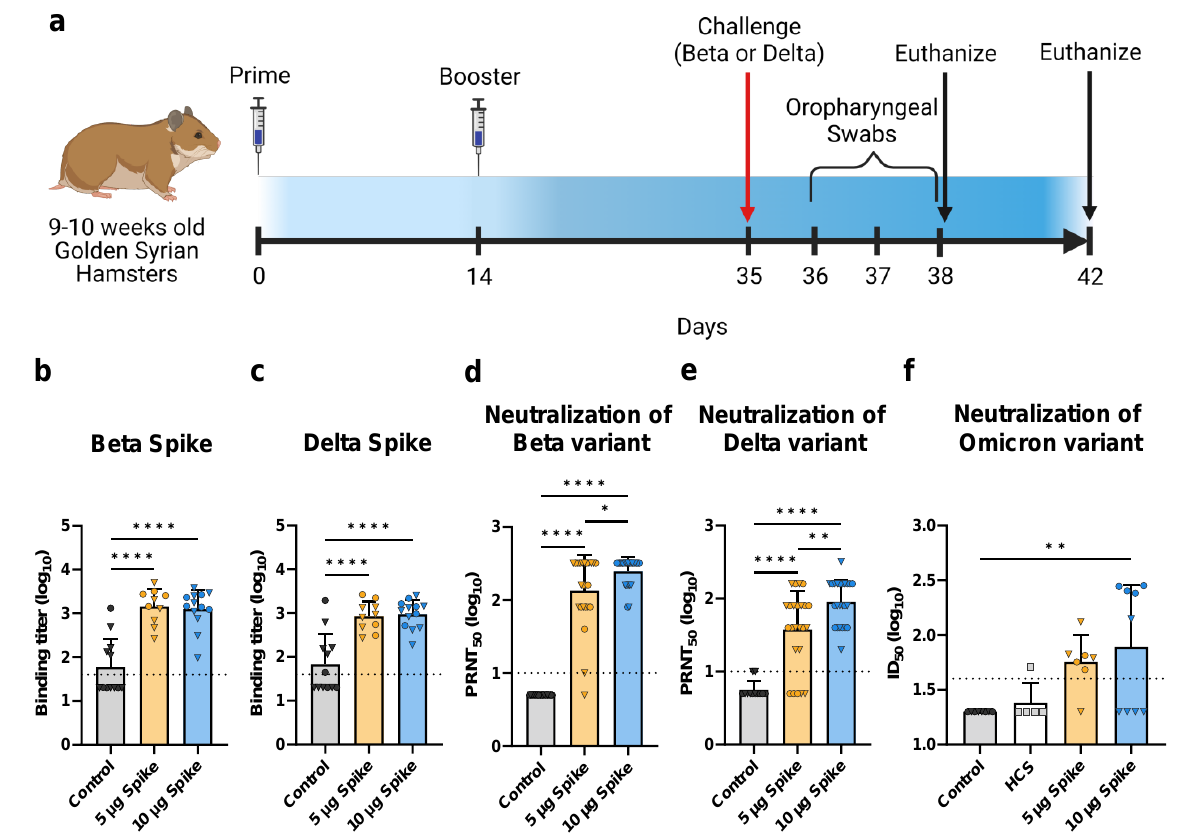
Figure 4. Hamster vaccination schedule and assessment of humoral immunity in response to bivalent VLP vaccination. ( a ) Immunization schedule for hamsters vaccinated with the bivalent (Beta and Delta) VLP vaccine adjuvanted with AddaVax. Bivalent VLPs were administered as either a low- (5 µg Spike) or high- (10 µg Spike) dose, and a third group was mock injected with only PBS (Control) ( n = 12/group per challenge variant). Sera were collected on day 35 and hamsters were subsequently challenged with either the Beta or Delta variant of SARS-CoV-2. Half the animals in each group were euthanized on day 38, and the remaining animals on day 42. ( b , c ) Spike-specific total IgG titers determined by ELISA using plates coated with either the ( b ) Beta variant Spike or ( c ) Delta variant Spike. Binding titer represents the dilution at which sera showed half of their maximal binding activity. Neutralizing activity was measured against both the ( d ) Beta and ( e ) Delta variants of SARS-CoV-2 using a plaque reduction neutralization test (PRNT). Neutralizing antibody titers are presented as the highest serum dilution at which 50% of the virus was neutralized relative to serum-negative controls (PRNT 50 ). ( f ) Neutralizing activity was measured against the Omicron variant using a pseudotyped lentivirus neutralization assay. Human convalescent sera (HCS) were also tested for neutralizing activity against Omicron. In ( b – f ), values for individual animals are presented as either circles ( ● ) for females or triangles ( ▼ ) for males. Dotted line indicates lower limit of detection. Data are mean + SD. Results were analyzed by one-way ANOVA with Tukey’s multiple comparisons test, with P < 0.05 considered significant. * P < 0.05, ** P < 0.01, **** P < 0.0001.